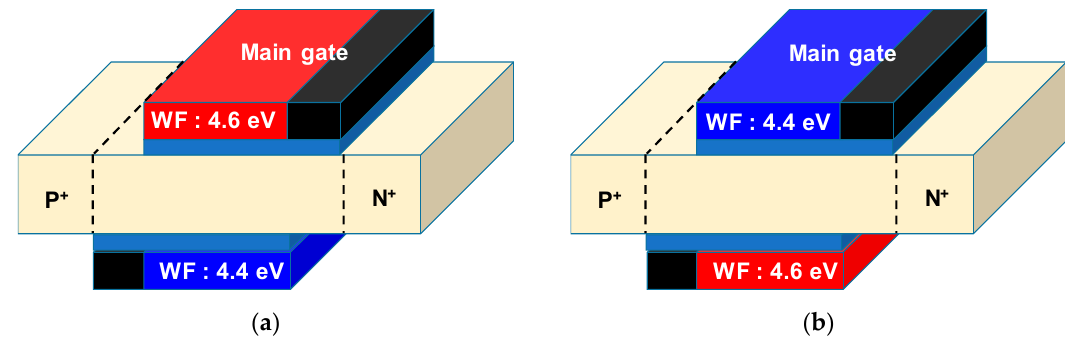
Figure 5. Expected metal grain distributions of EHBTFETs in the most extreme theoretical cases (red color: metal grains with a WF of 4.6 eV, blue color: metal grains with a WF of 4.4 eV, and black color: metal grains that have less effect on the V turn-on of EHBTFET). ( a ) Expected maximum V turn-on case of EHBTFETs in theory. ( b ) Expected minimum V turn-on case of EHBTFETs in theory.